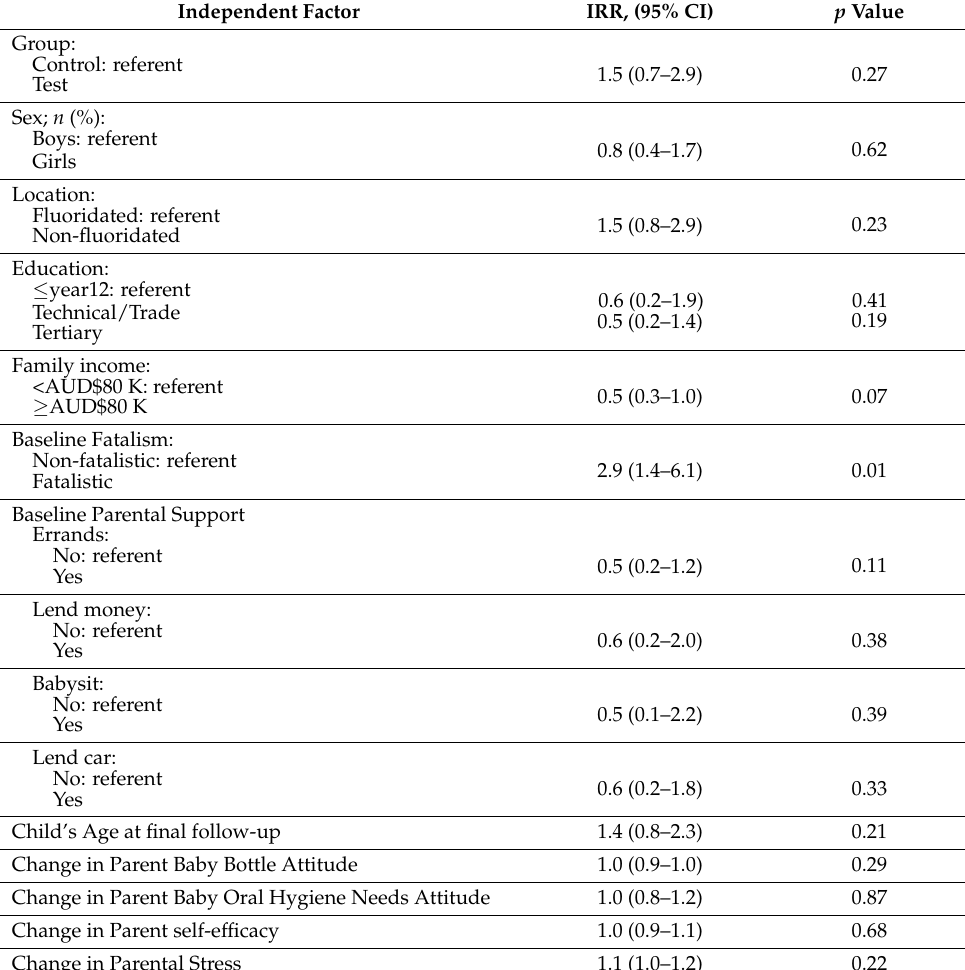
Table 4. Univariable negative binomial regression of independent factors for the count of caries experience (dmfs, decayed, missing, filled surfaces) with robust standard errors, coefficients presented as incident rate ratios